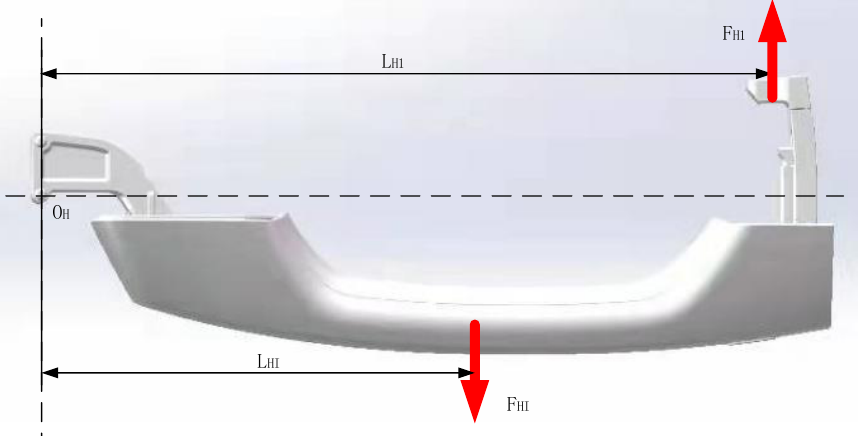
Figure 8. Schematic diagram of handle force.